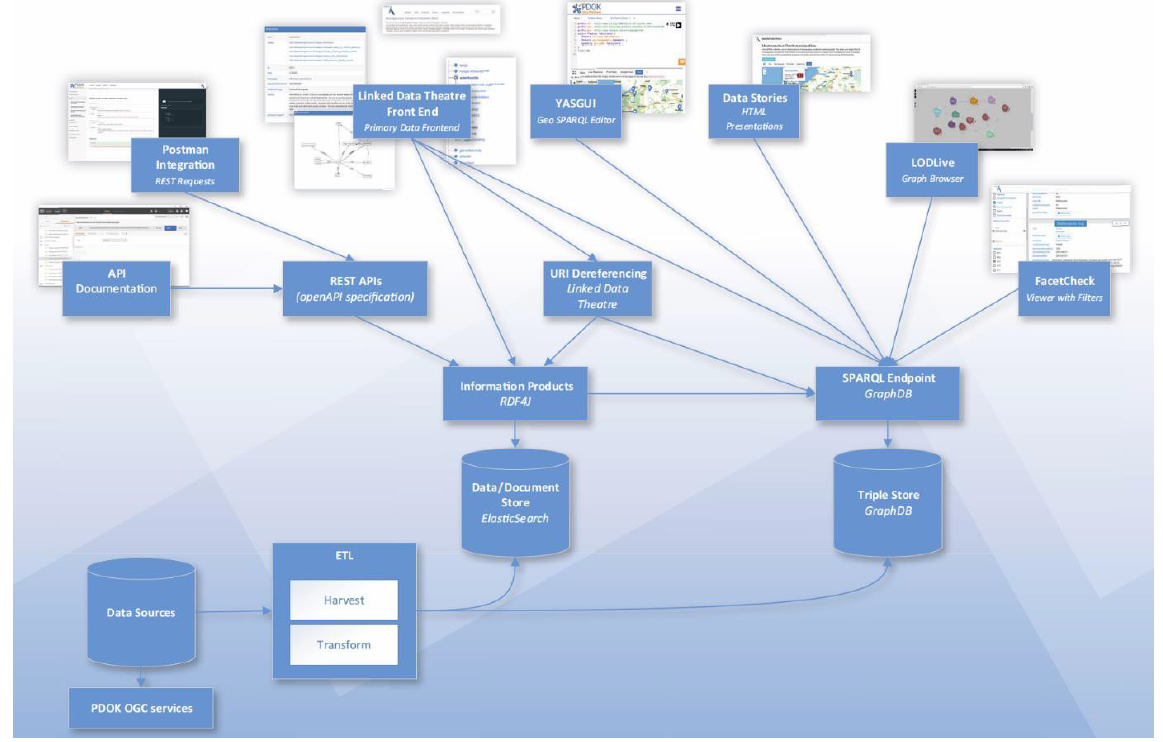
Figure 1. The Kadaster Data Platform (KDP)